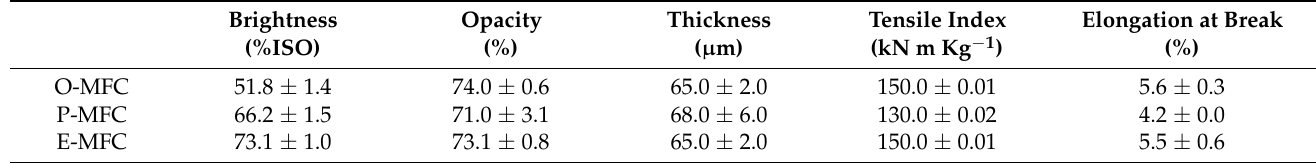
Table 4. Brightness, opacity, thickness, tensile index and elongation at break of MFC films.